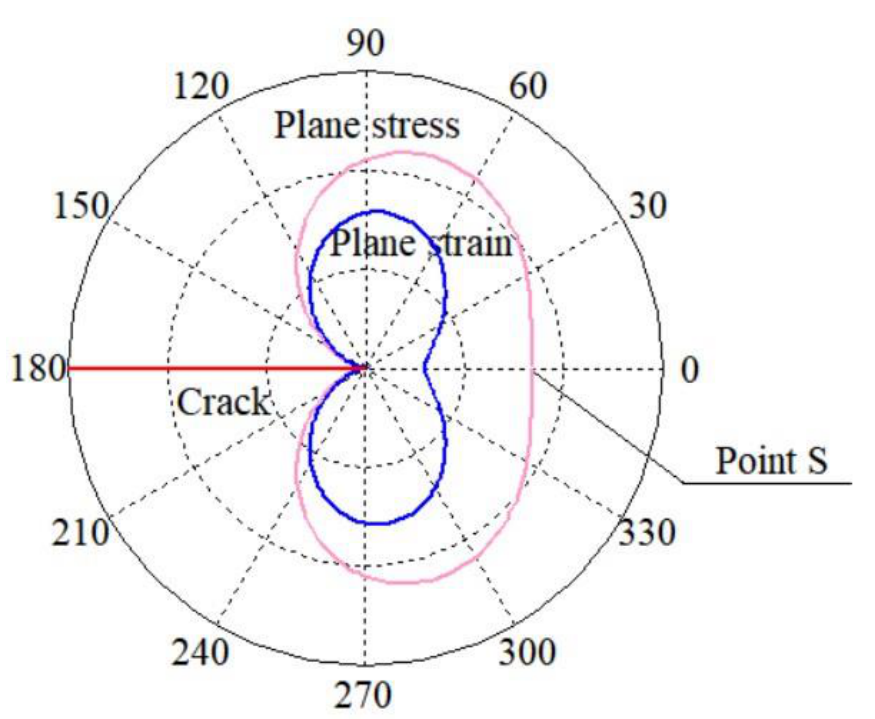
Figure 6. Theoretical shape of the plastic zone.